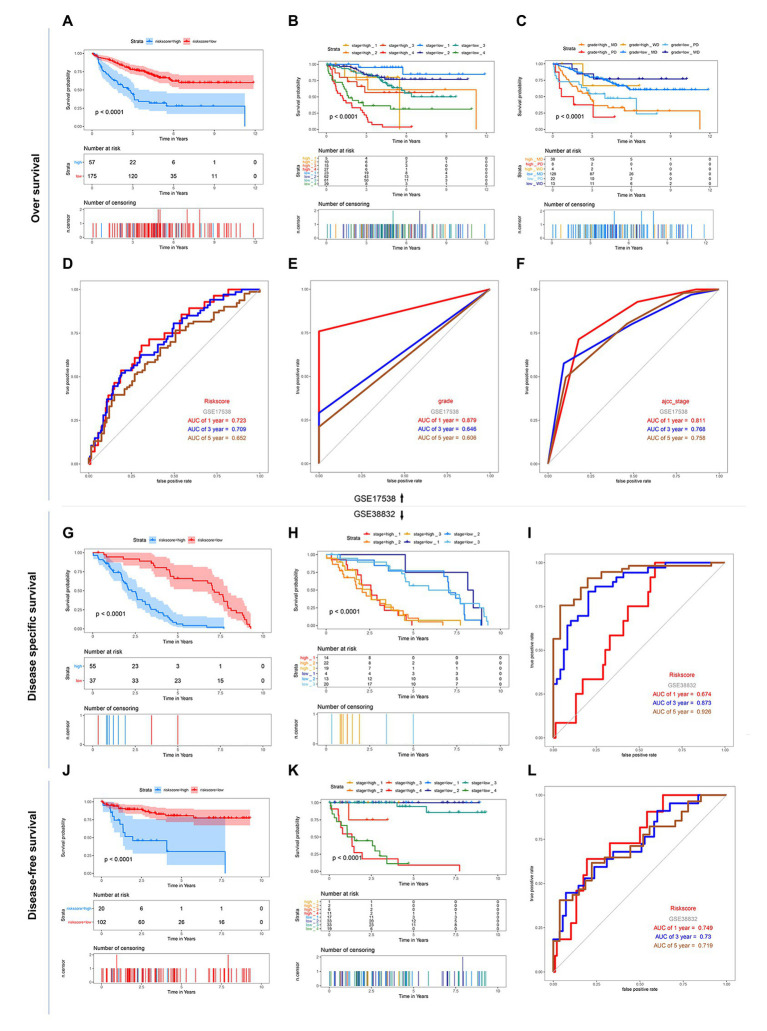
Kaplan-Meier survival and ROC curves of the 12-DNA signature, grade and stage in the two GEO sets. (A) Correlation between the 12-DNA signature and the overall survival of patients in the GSE 17538 set. (B,C) Kaplan-Meier survival for OS in high-risk and low-risk group of different subgroup in the GSE 17538 set: in subgroups stratified by stage I, stage II, stage III, and stage IV, in subgroups stratified by grade MD, grade PD, and grade WD. (D–F) ROC curve analysis of risk score, stage and grade according to the 1, 3, 5, and 10-year survival of the area under the AUC value in the GSE 17538 set. (G) Correlation between the 12-DNA signature and the disease specific survival of patients in the GSE 38832 set. (H) Kaplan-Meier survival for disease specific survival in stage 1, 2, and 3 subgroups of high-risk and low-risk group in the GSE 38832 set. (I) ROC curve analysis of risk score according to the 1, 3, and 5-year disease specific survival of the area under the AUC value in the GSE 38832 set. (J) Correlation between the 12-DNA signature and the disease-free survival of patients in the GSE 38832 set. (K) Kaplan-Meier survival for disease-free survival in stage 1, 2, 3, and 4 subgroups of high-risk and low-risk group in the GSE 38832 set. (L) ROC curve analysis of risk score according to the 1, 3, and 5-year disease-free survival of the area under the AUC value in the GSE 38832 set.